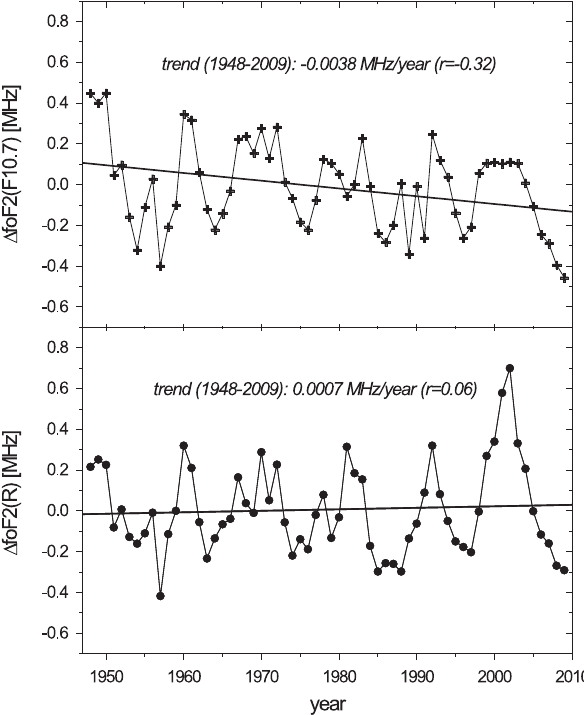
Fig. 7. Global mean fo F2 trends by use of F10.7 (upper part) or R data (lower part) in the trend